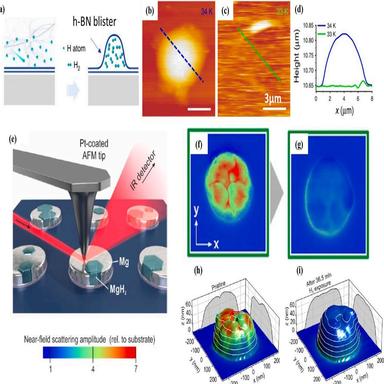
(a) Schematics of the h-BN blisters formation in hydrogen plasma atmosphere, SPM topography images of the same h-BN blister under (b) 34 K and (c) 33 K, and (d) corresponding height profile along the dashed lines in (b, c). (e) Schematic of SPM equipped with s-SNOM; near-field scattering amplitude images can be visualized through an IR detector and a scattered laser beam. (f, g) Near-field scattering images of Mg nanoparticles in the area of 600 × 600 nm2 and (h, i) topography depicted as 3D surface overlai